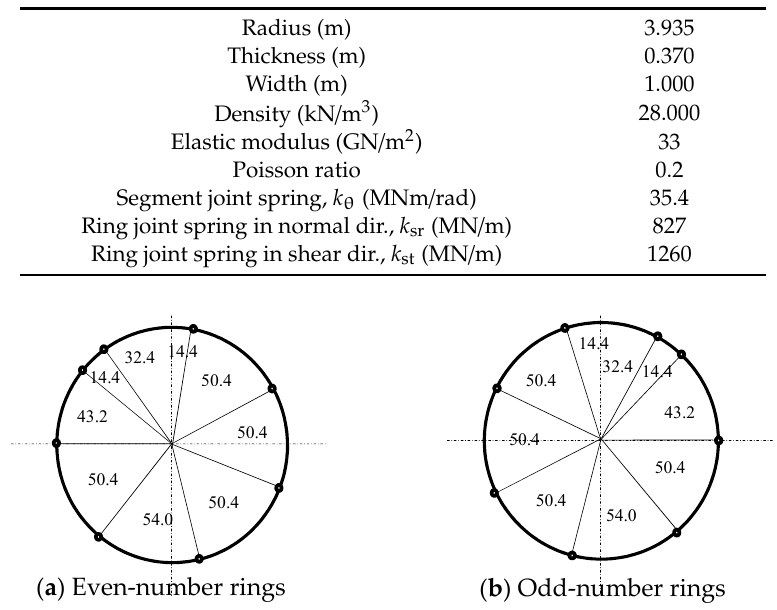
Table 3. Segmental lining dimensions and material properties.